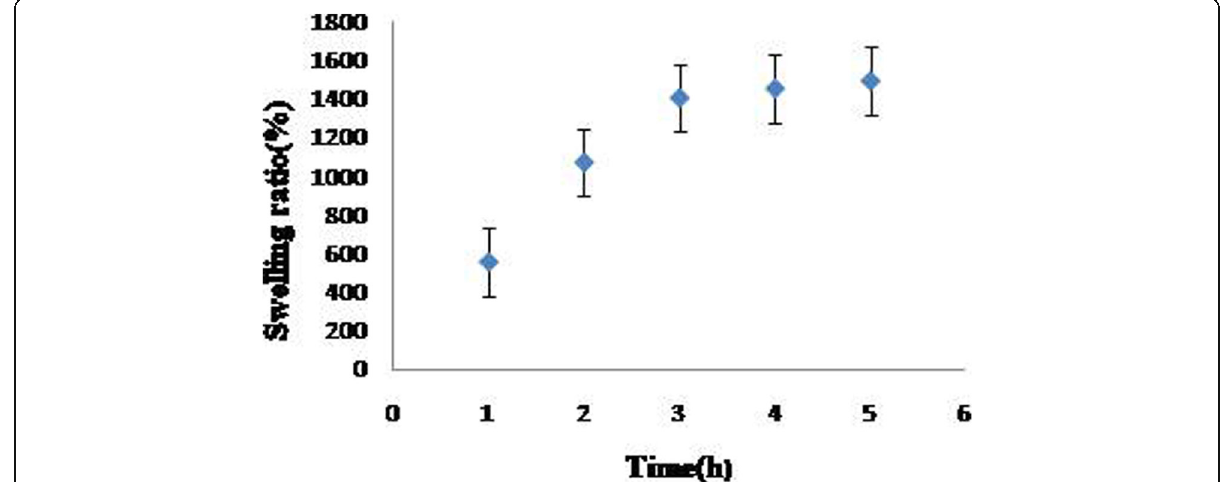
Fig. 2 Swelling kinetics of Ca-ALG NP exposed to phosphate buffer (pH